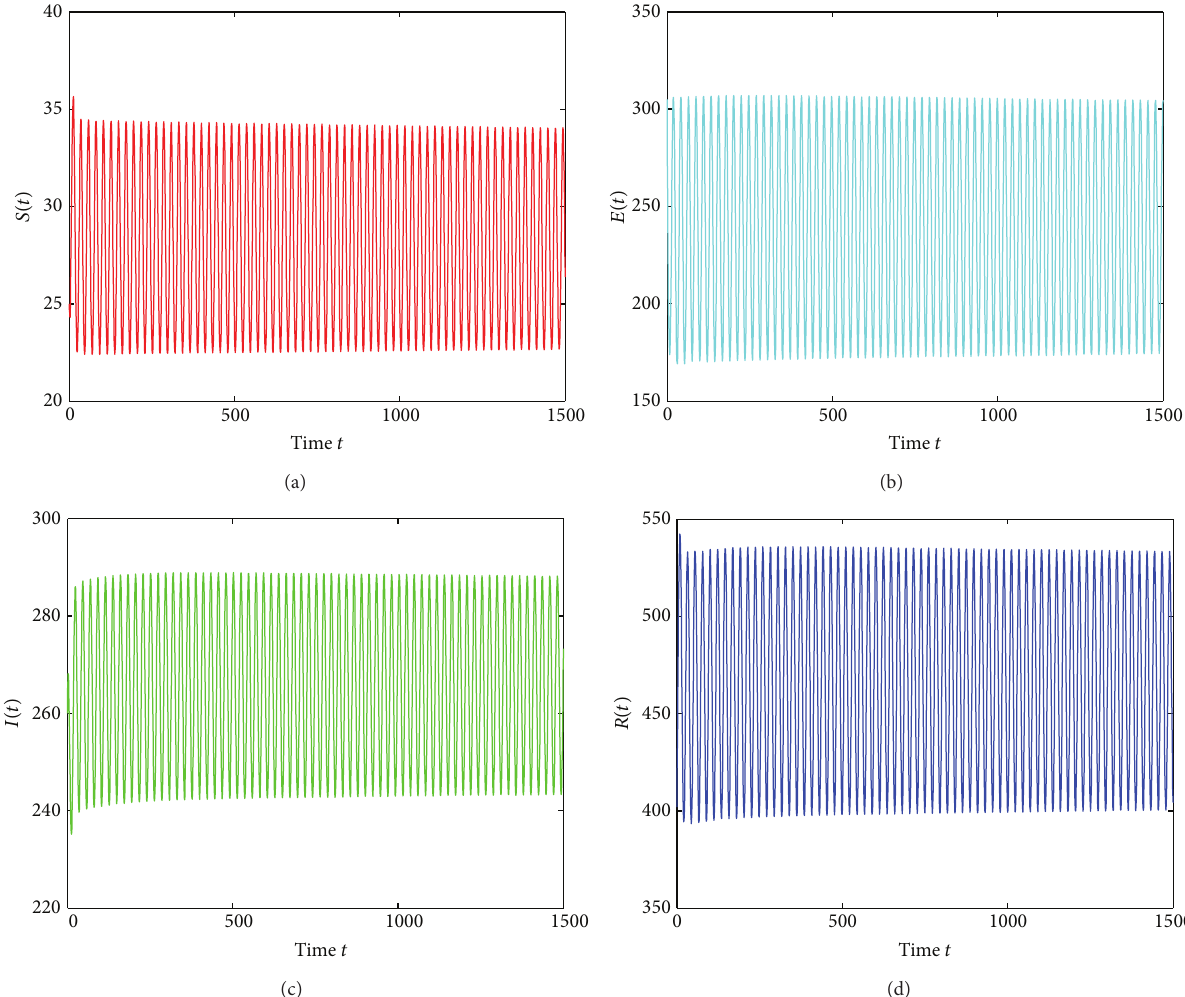
Figure 15: The track of the states 𝑆 , 𝐸 , 𝐼 , and 𝑅 for 𝜏 1 = 8.4500 > 7.8533 = 𝜏 ∗ 1 and 𝜏 ∗ 2 = 3